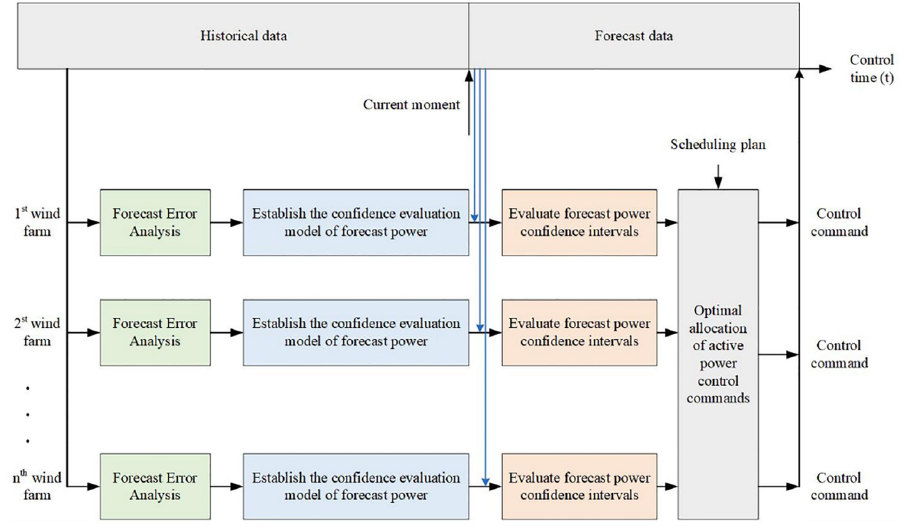
Fig 2. Wind power active power control